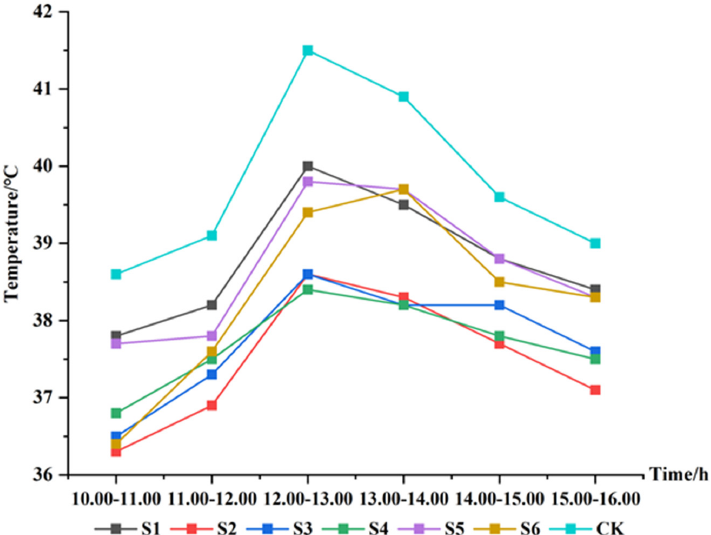
Figure 6. Air temperature diurnal variation of the tree species (S1–S6).